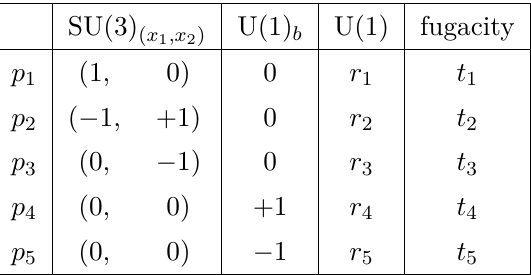
Table 19 . Global symmetry charges on the extremal brick matchings p i of Model